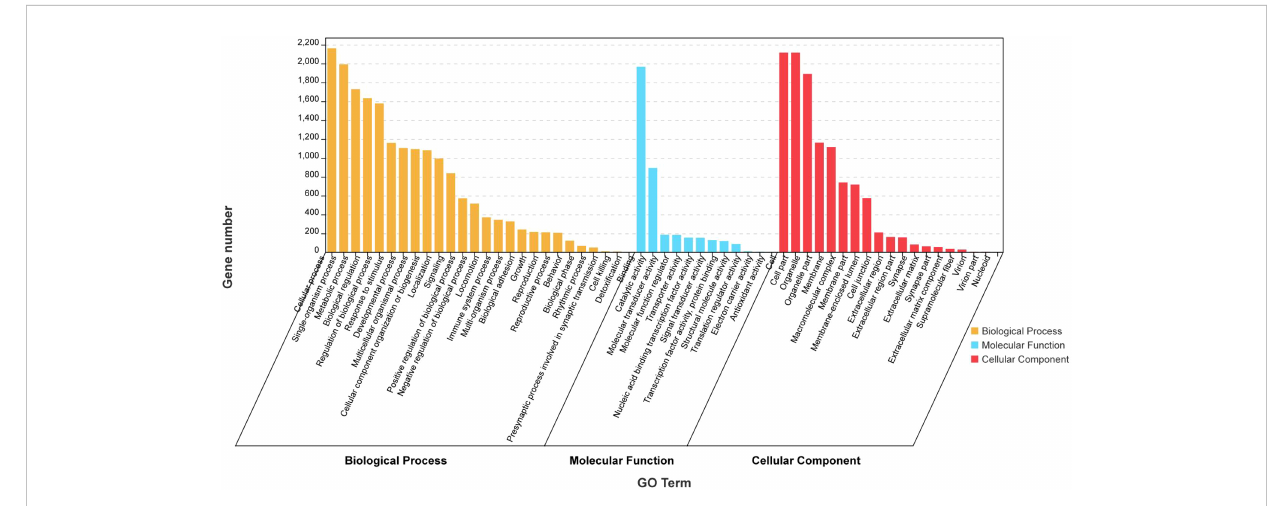
FIGURE 4 GO analysis of the differentially expressed genes (DEGs) obtained from RNA-seq data of stage III and IV ovary of S. argus